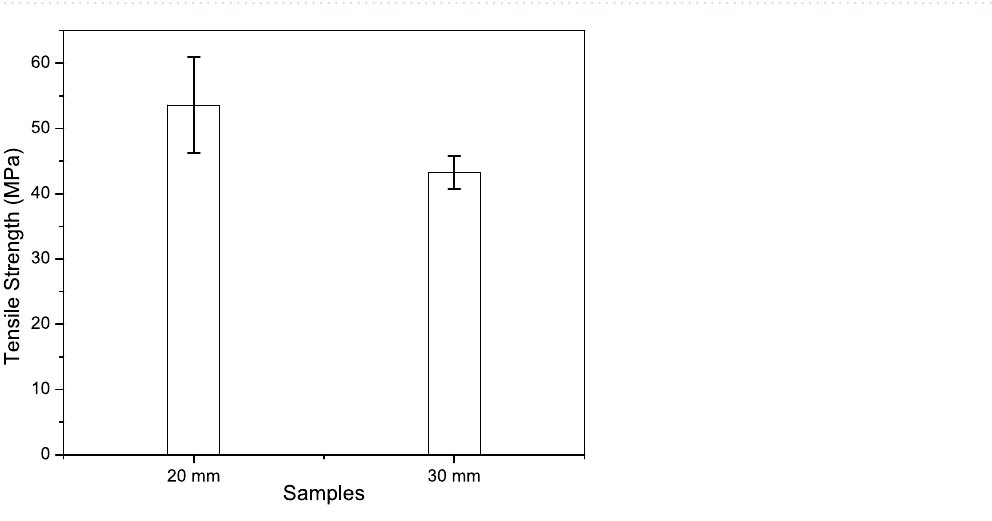
Figure 6. Tensile strength curve of CTF